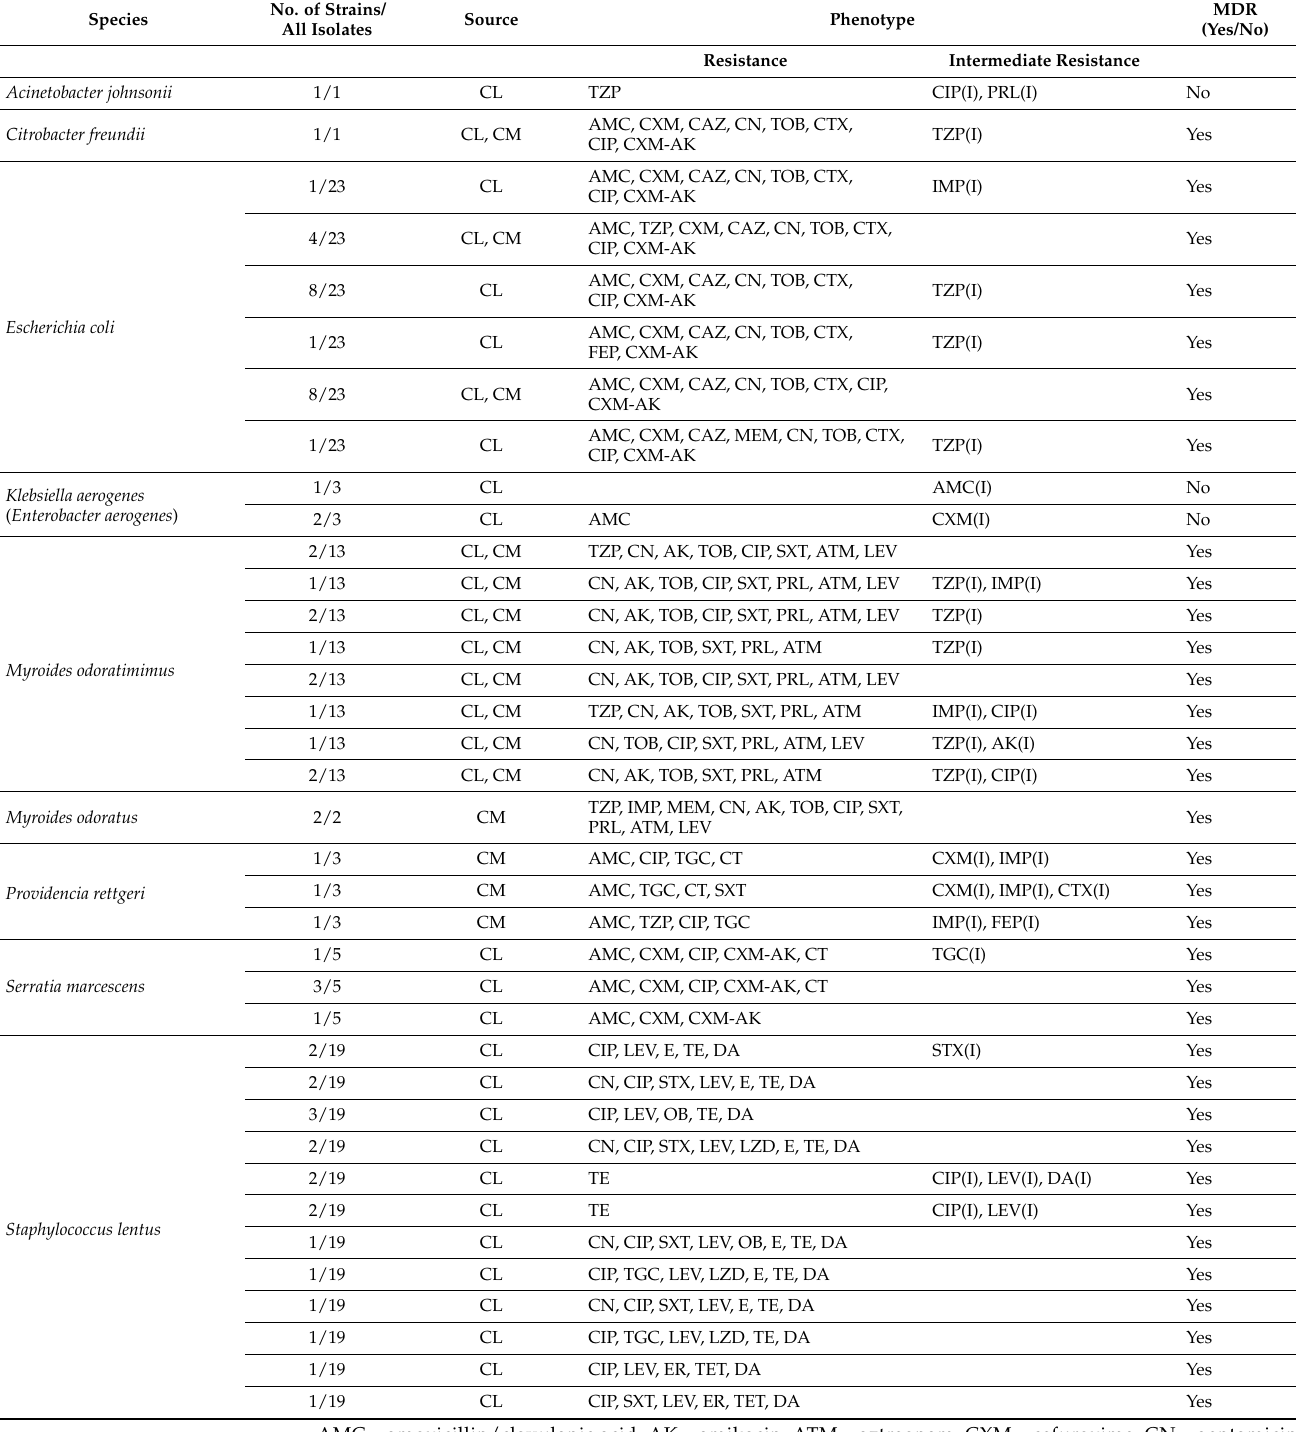
Table 4. Antibiotic-resistance phenotypes of isolated strains from two types of chicken wastes—CL and